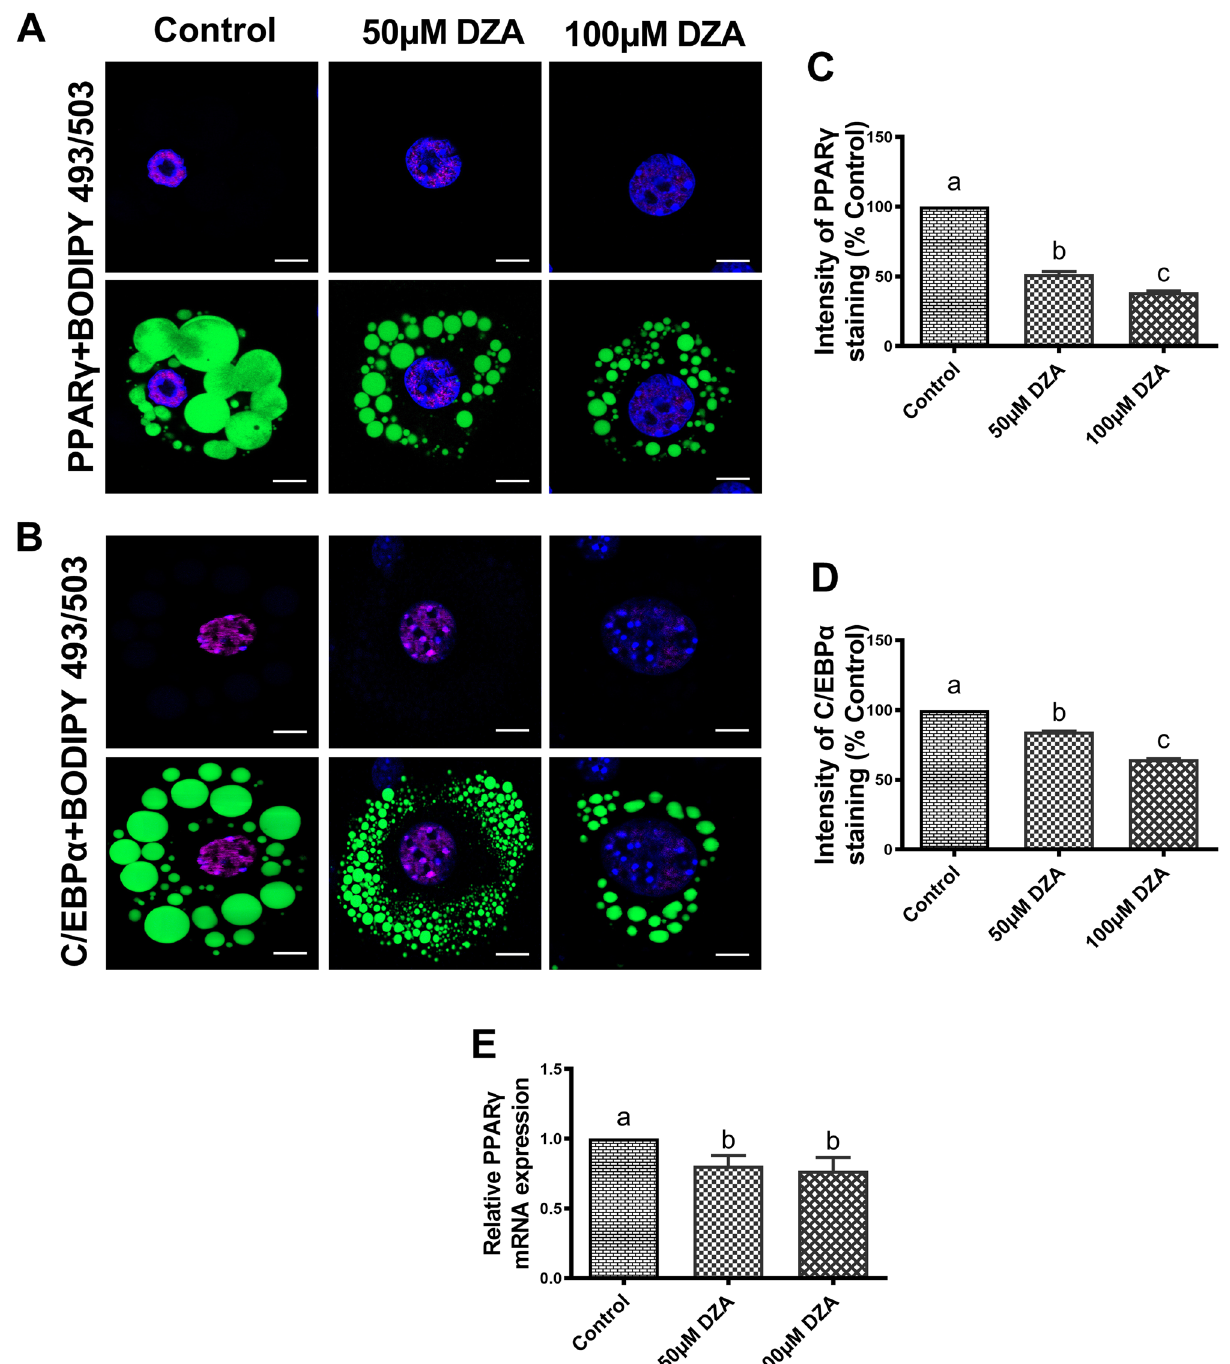
Figure 8. DZA alters the expression of adipocyte differentiation markers. ( A ) Representative immunofluorescence image of ( A ) PPARγ and ( B ) C/EBPα in BODIPY 493/503 and DAPI stained control and DZA-treated 3T3-L1 adipocytes (Scale bar—20 µm) and fluorescence intensity of ( C ) PPARγ and ( D ) C/EBPα in representative DZA-treated cells normalized to % of control cells, n = 5 experiments; images of 32 random cells from each treatment group per experiment were captured using confocal microscope. ( E ) Relative mRNA expression levels of PPARγ in control and DZA-treated 3T3-L1 adipocytes (n = 6). Data are presented as the mean ± SEM; values not sharing a common letter significantly differ from each other at p ≤